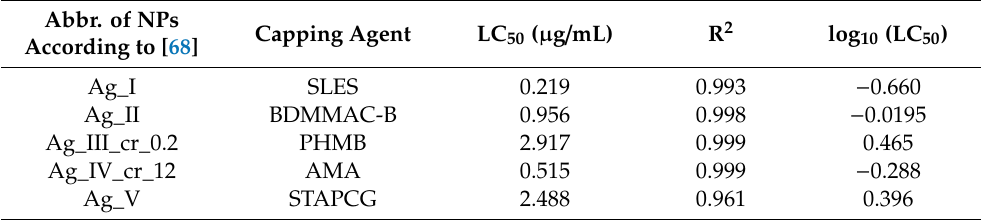
Table 6. LC 50 values for silver NP dispersions in zebrafish embryos after 96 h of exposure.